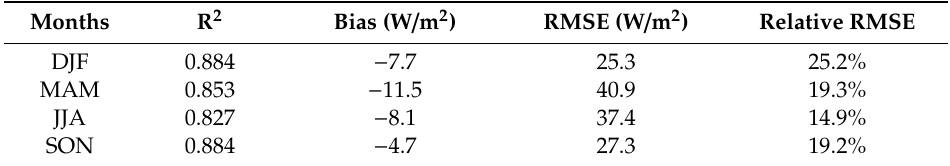
Figure 7. Validation results of the daily MCD18A1 DSR product using the BSRN 2018 DSR measurements. Table 4. Validation results of MCD18A1 daily DSR by seasons (DJF: December, January, and February; MAM: March, April, and May; JJA: June, July, and August; SON: September, October, and